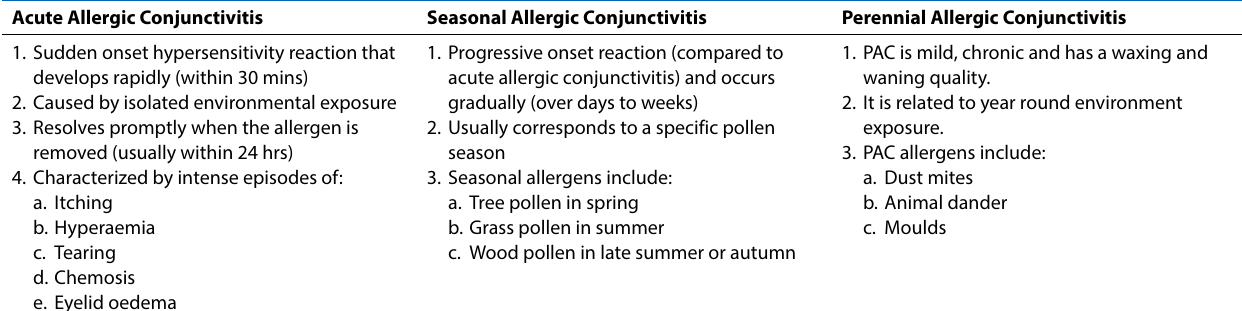
Table 1: Key differences between the three types of allergic conjunctivitis 1,6,15-17 Acute Allergic Conjunctivitis